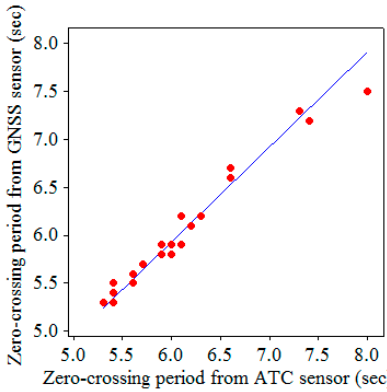
Figure 11. Scatter plot and regression line for the zero-crossing periods.